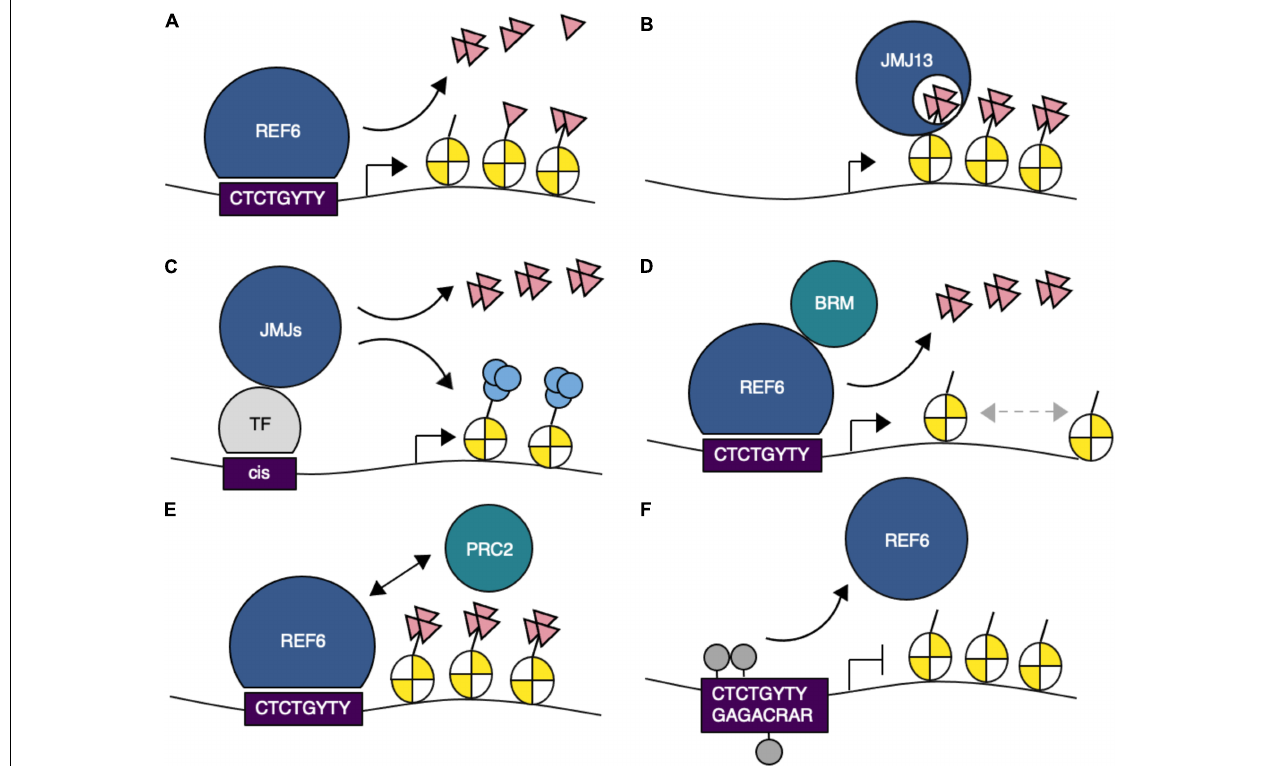
FIGURE 2 | Schematic representation of the function of H3K27me3 demethylases in gene regulation. (A) REF6 demethylates H3K27me1/2/3 via recognition of CTCTGYTY (where Y is C or T) DNA motifs. (B) JMJ13 recognizes H3K27me3 marks. (C) JMJ proteins interact with transcription factors and are recruited to their target sites. (D) REF6 interacts with BRAHMA (BRM) and mediates nucleosome positioning. (E) REF6 prevents the uncontrolled spreading of PRC2-mediated chromatin silencing. (F) DNA methylation at CTCTGYTY motifs prevents REF6 targeting. H3K27me3, pink triangles; H3K9ac, light blue circles; DNA methylation, gray